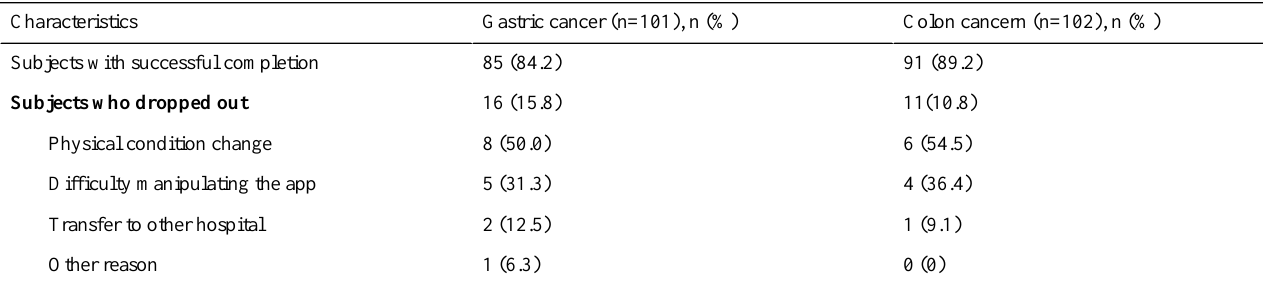
Table 3. Study completion rates of study subjects.